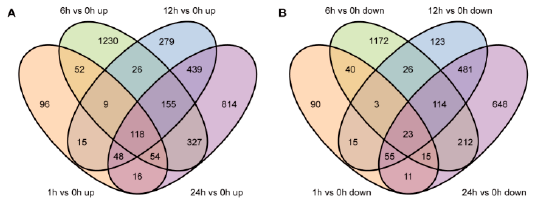
Figure 4. Venn diagrams illustrating the unique and shared differentially expressed genes that were ( A ) up- or ( B ) downregulated by C. medinalis infestation through the time course.